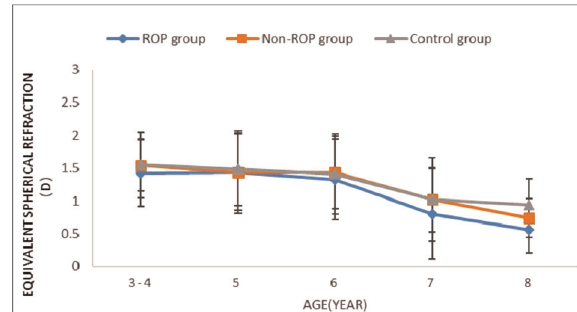
FIGURE 1 Change in SE in subjects aged 3-8 years. ROP=retinopathy of prematurity; D=dioptres. * Signi fi cant differences among the study groups ( P <0.05, one-way analysis of variance, least signi fi cant